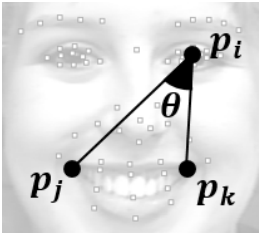
Fig. 3. An example of a facial